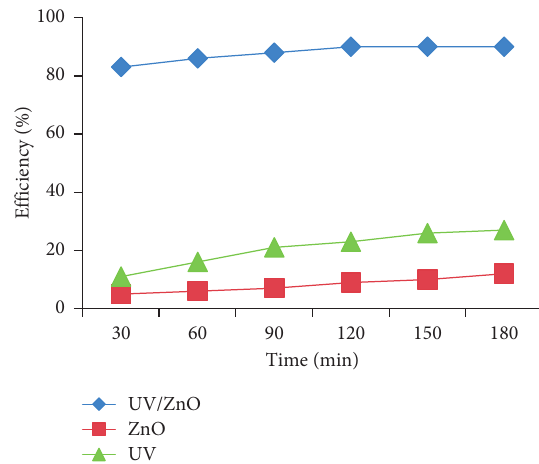
Figure 4: TMP removal by different treatment processes (TMP � 0.5mg/L) ( P value �